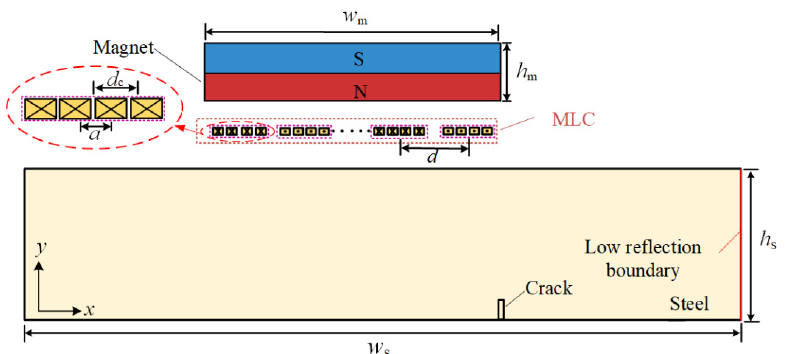
Figure 3. Schematic diagram for the design parameters of the angled SV wave EMAT. Table 1. Design parameters and values of angled SV wave EMAT.